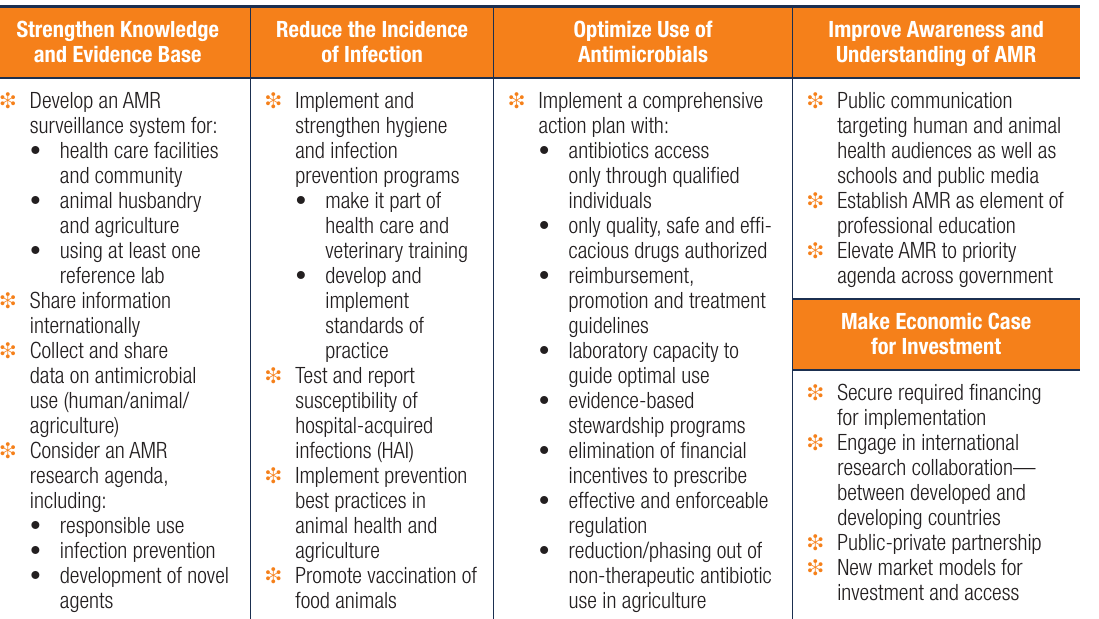
FIGURE ES4. Five Objectives of the Global Action Plan on AMR,